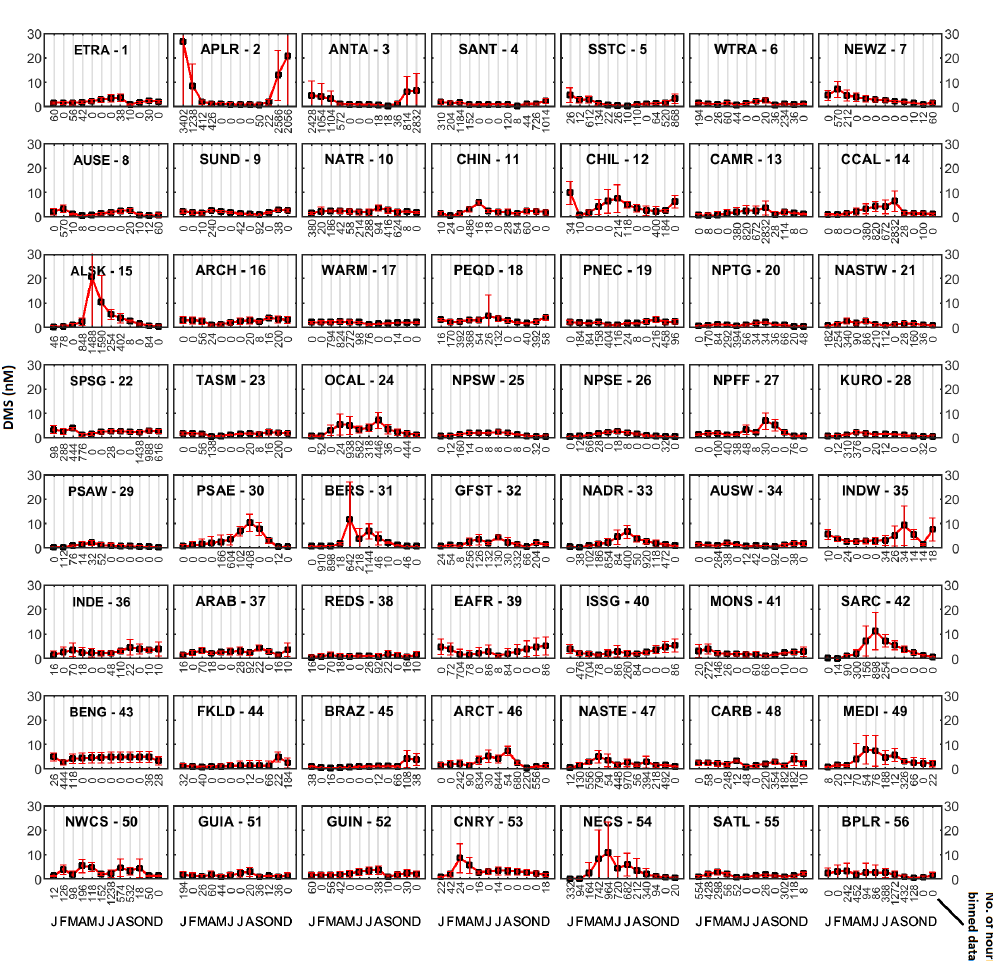
Figure 4. The substituted and interpolated monthly mean data (black squares) with respective standard deviations for each province are shown. The number of hourly binned observations in a month is shown below the x -axis, where 0 indicates that the data were